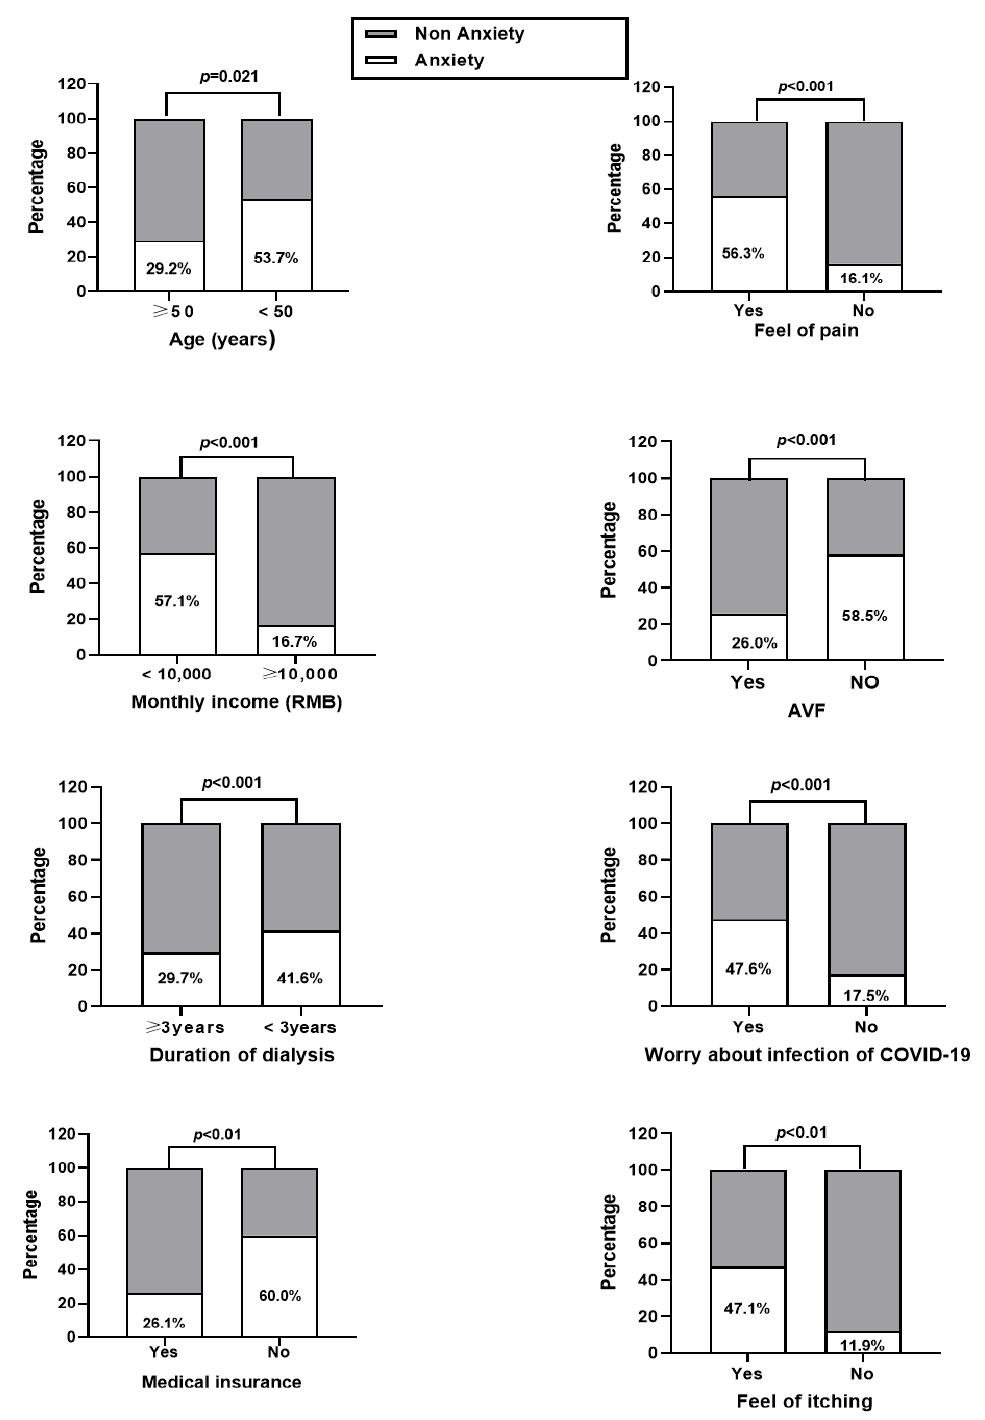
Figure 1. Single-factor analysis of anxiety in the MHD patients with different demographic charac- teristics.